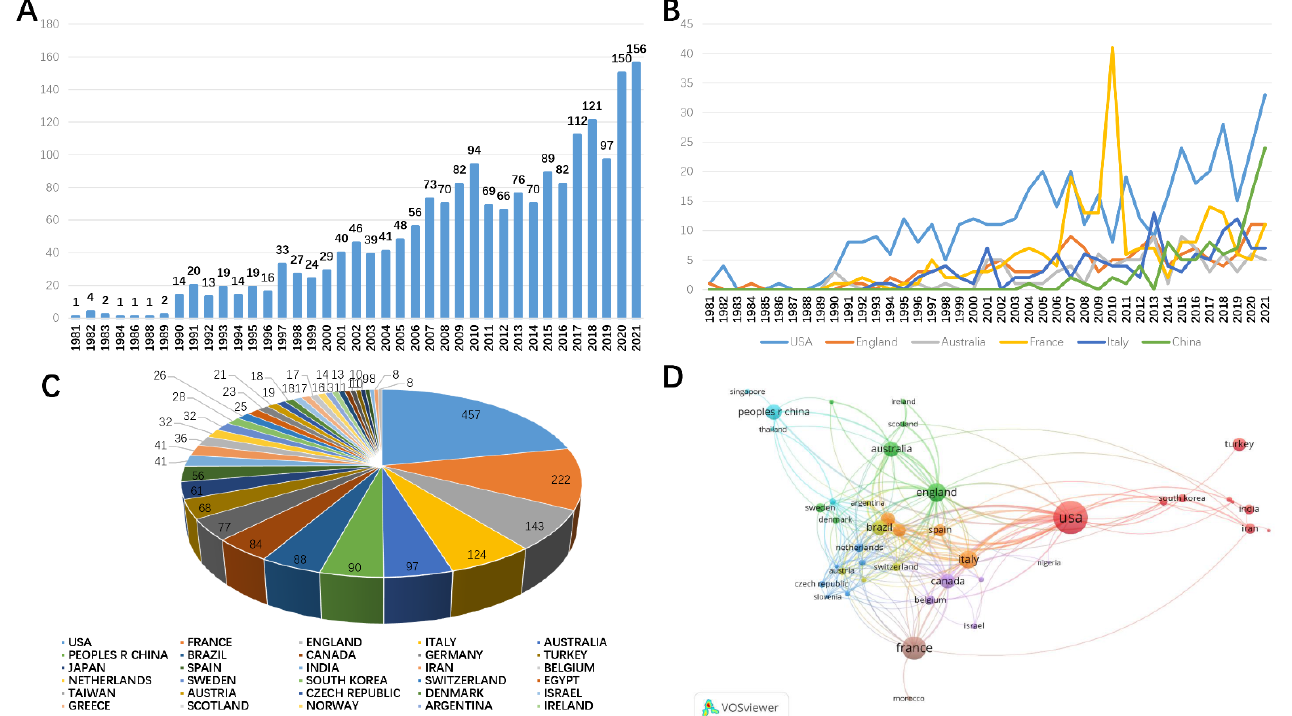
Figure 1. Overview of perineal pain-related articles. ( A ) The number of perineal pain publications across the world from 1981 to 2021. ( B ) The time curve of perineal pain-related articles from the top six countries. ( C ) The number of articles from each country/region. ( D ) A network map showing the collaborative relationships between various countries in the field of perineal pain research.